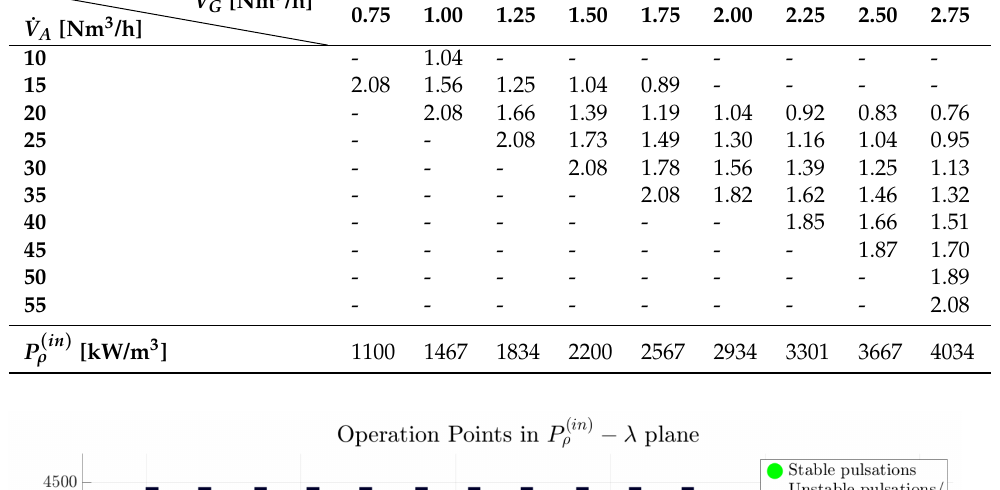
Table 1. Overview of the measured operation points in terms of the air–fuel equivalence ratio, λ (the central part of the table), and of the power density input, P OPs are determined by a combination of the gas and the airflow rate - ˙ V G and ˙ V A , respectively. The use of a hyphen means that stable pulsating combustion could not be reached for the particular flow rate combination.